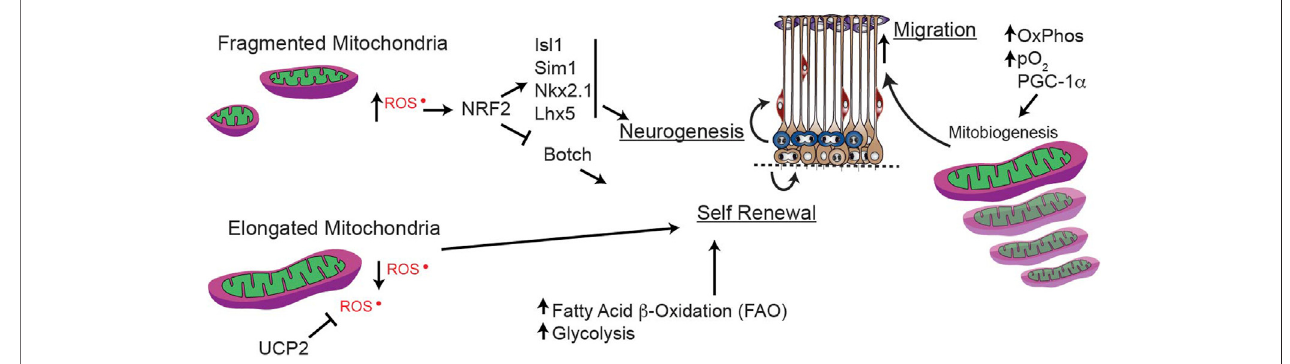
FIGURE6| Mitochondrialdynamicsduringforebrainneurogenesis.Mitochondrialdynamicsandmitochondrialgenerationreactiveoxygenspecies(ROS)andfatty acid oxidation (FAO) play key roles in maintaining the balance between stemness and terminal differentiation to immature neuron.